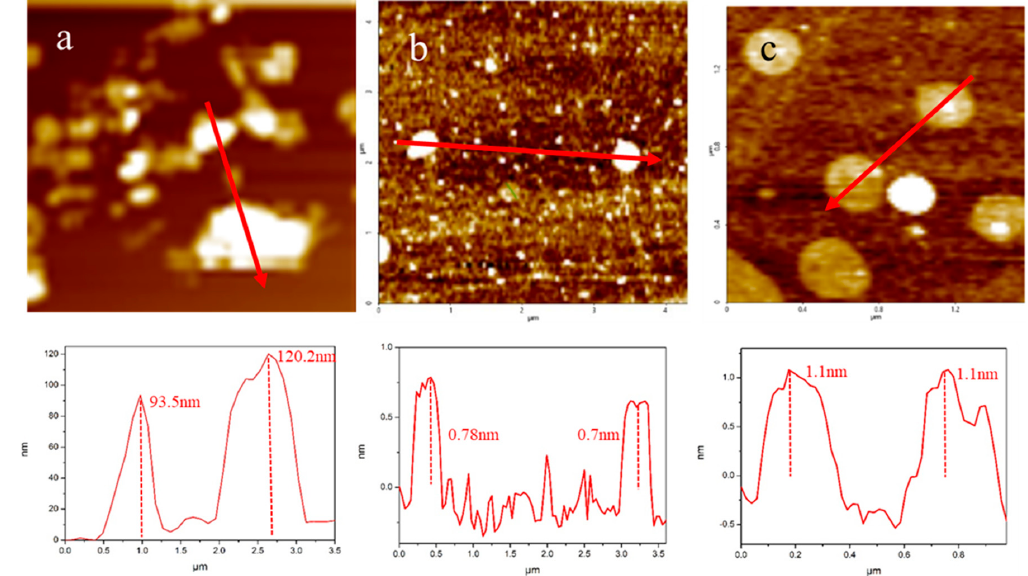
Figure 3. Atomic force microscope (AFM) images of: ( a ) bulk MoS 2 , ( b ) MoS 2 -ethanethiol, and ( c ) MoS 2 -nonanethiol.